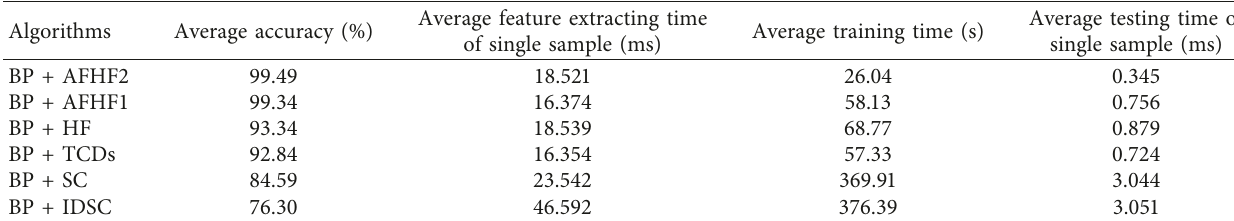
Table 6: Experimental results on actual measured shaft orbit dataset by BP neural